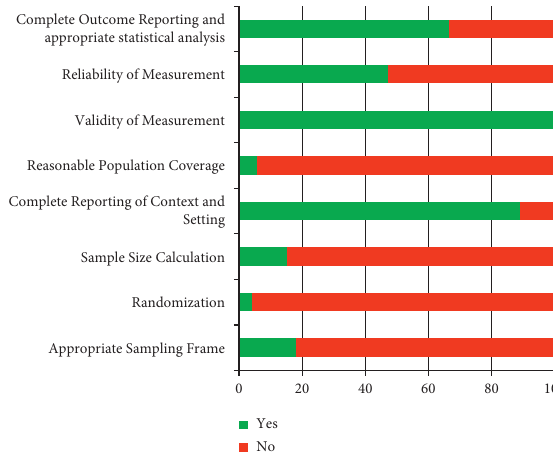
Figure 5: Summary of research methodology of the included